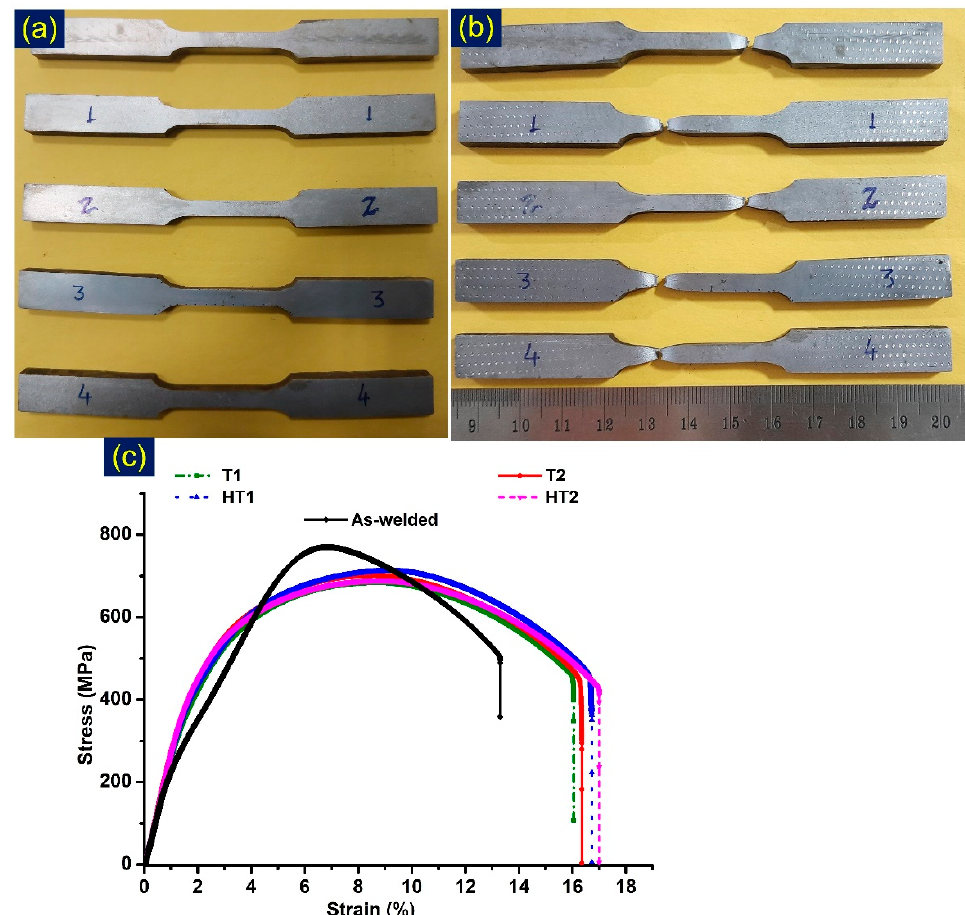
Figure 20. ( a ) Tensile specimens before testing and ( b ) after testing; ( c ) stress–strain curve for tested specimens.